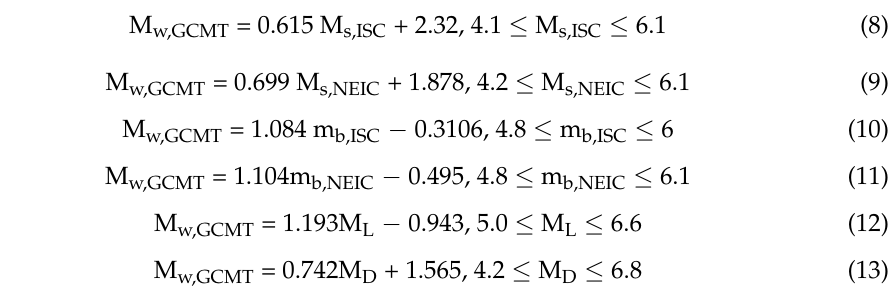
Figure 15. Plot showing the GOR connection for intensity scaling (MMI) to M wg,GCMT . Ref. [5] derived the GOR1 relationships between M w and MMI for the same